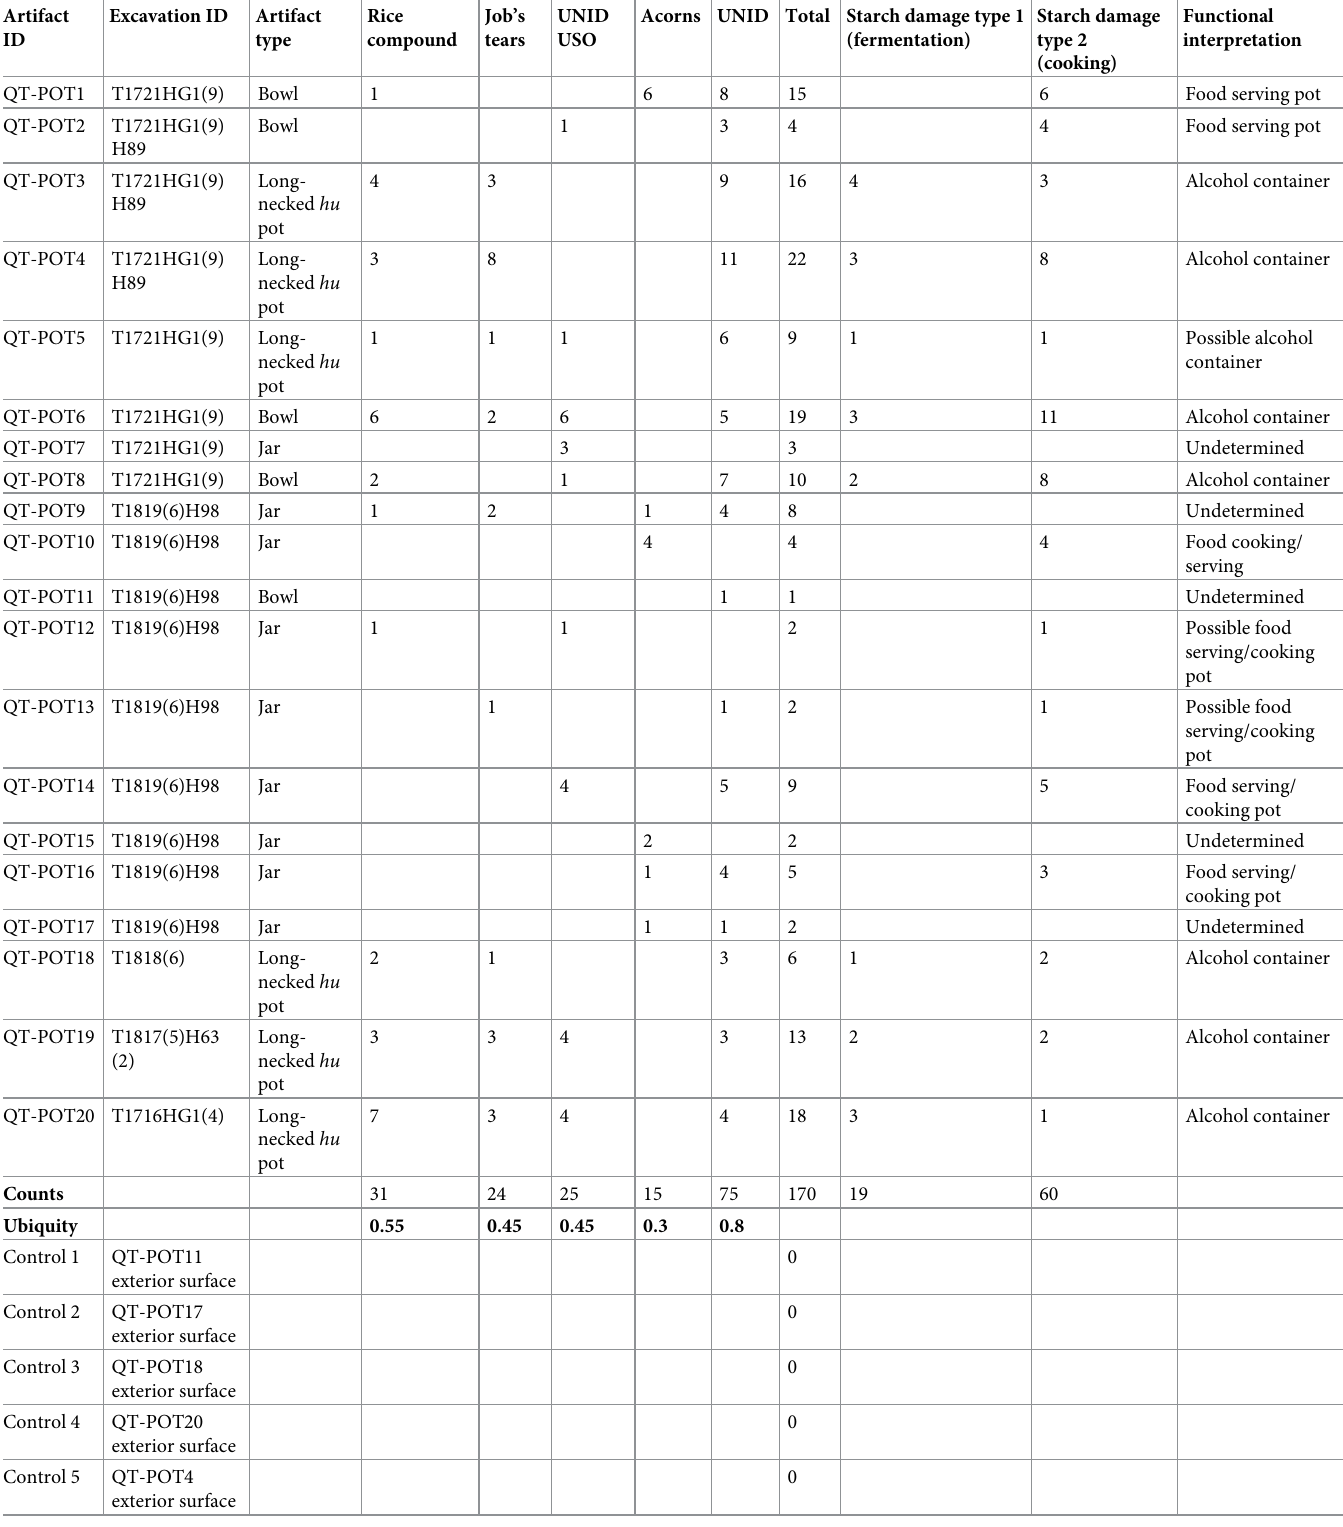
Table 1. Starch data from